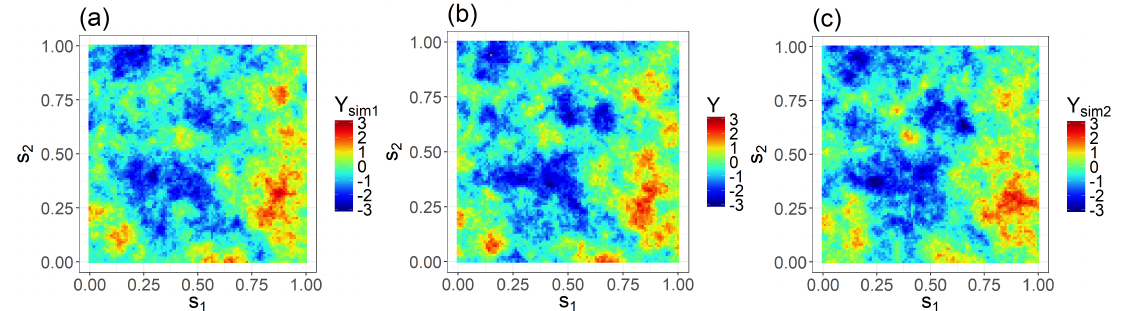
Figure 2. Conditional simulations from the Level 3 product (see the main text for details). ( a ) First conditional simulation; ( b ) the true process (identical to Figure 1b); ( c ) second conditional